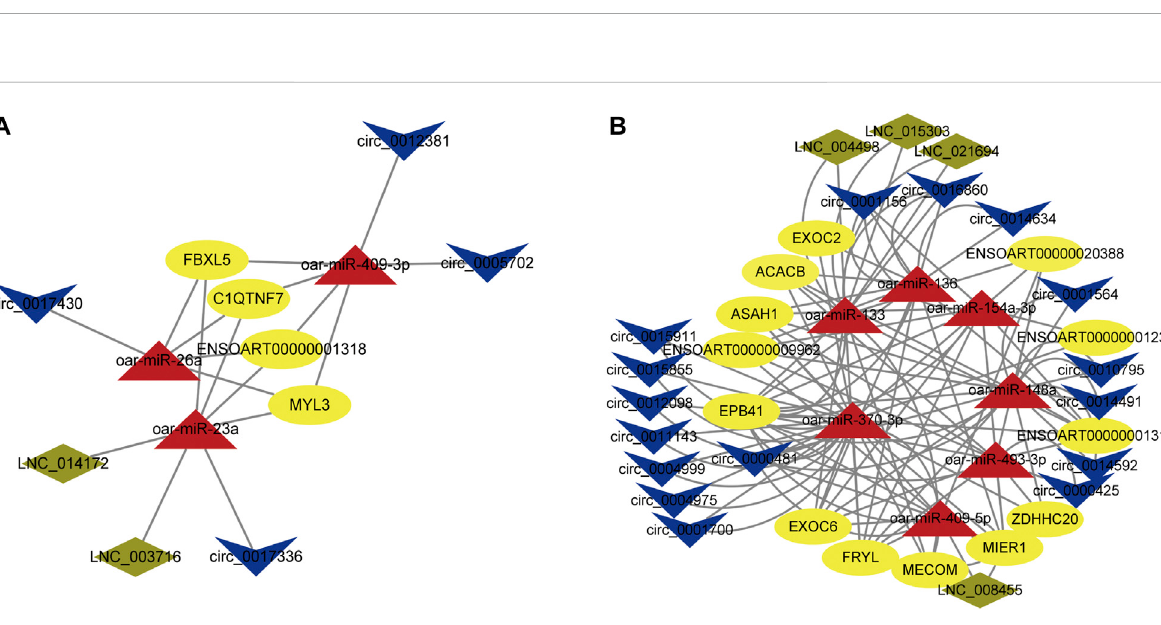
ceRNA network construction in differnt muscle tissues. (A) LncRNA/circRNA-miRNA-mRNA interaction network was constructed based on different expression levels in the longissimus dorsi of Tan sheep and Dorper sheep. (B) LncRNA/circRNA-miRNA-mRNA interaction network was constructed based on different expression levels in the biceps femoris of Tan sheep and Dorper sheep. The ovals, triangles, parallelograms and V types represent mRNAs, miRNAs, IncRNAs and circRNAs